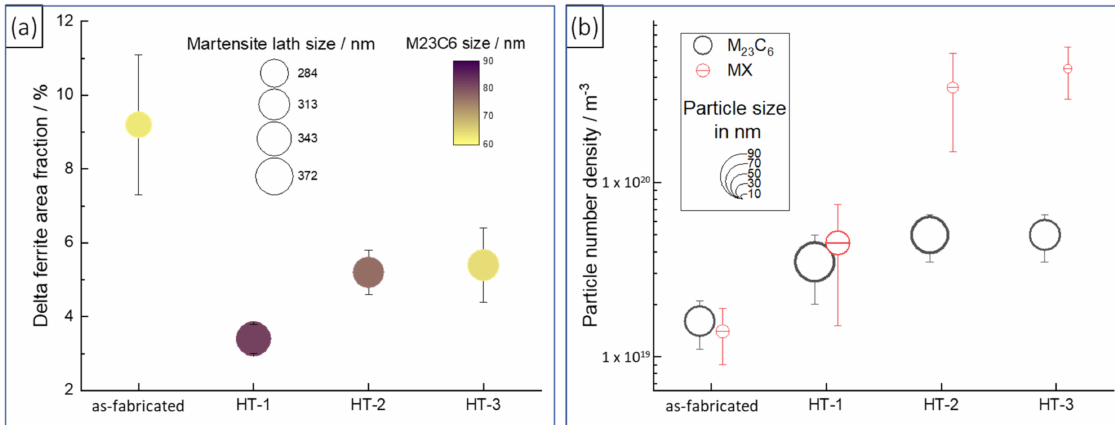
Figure 18. ( a ) Delta ferrite area fraction, martensite lath size and M 23 C 6 sizes plotted in relationship to the heat treatment; ( b ) particle number density and particle sizes of MX and M 23 C 6 precipitates are plotted for all